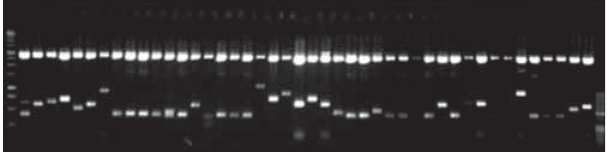
Figure 3. Restriction cleavage of plasmids purified from transformant colonies. First lane is 1 kB Gene Ruler (Fermentas, Biocenter, Hungary) and the last lane is 50 bp Gene Ruler (Fermentas, Biocenter, Hungary). Plasmids are about 3000 bp while the inserts have different lengths. Out of forty-four plasmids forty-three were send to sequence